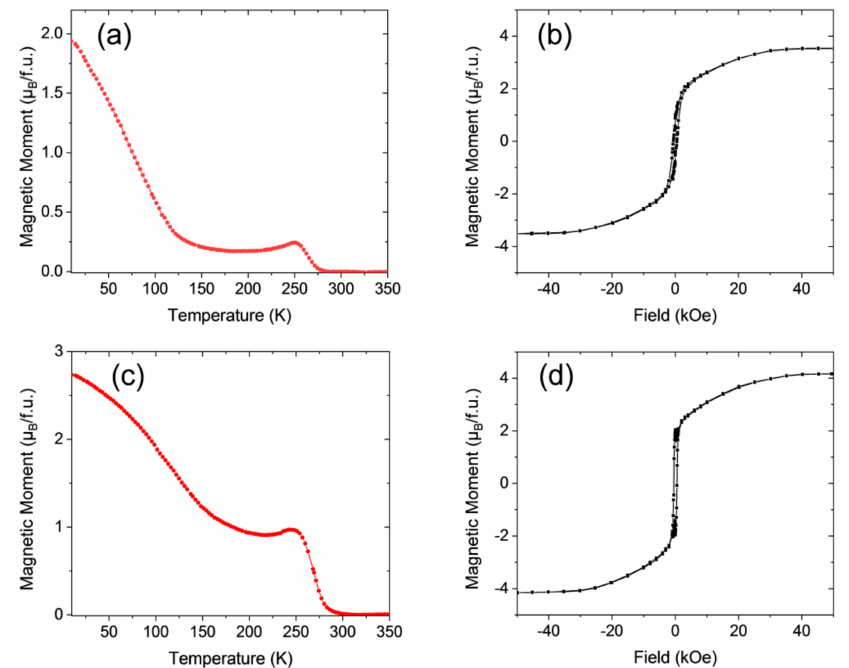
Figure 6. ( a ) Magnetization vs. temperature of a LNMO / LAO − 1 epitaxial film thermally treated in RTA conditions, measured after field cooling with a magnetic field of 1 kOe applied parallel to (100)-LAO, (in-plane). ( b ) M–H loop of the same sample recorded at 10 K by applying the magnetic field H in-plane. ( c ) Temperature dependence of the magnetization under an in-plane applied magnetic field of 1 kOe, of sample LNMO / LAO − 1R. ( d ) M–H loop of sample LNMO / LAO − 1R recorded at 10 K by applying